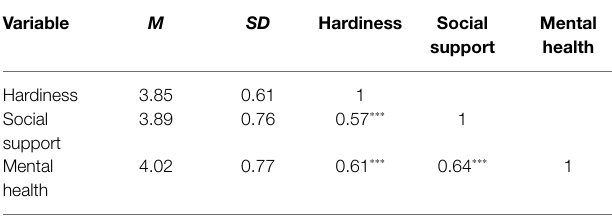
TABLE 2 | Descriptive statistics of and correlation between the investigated variables.